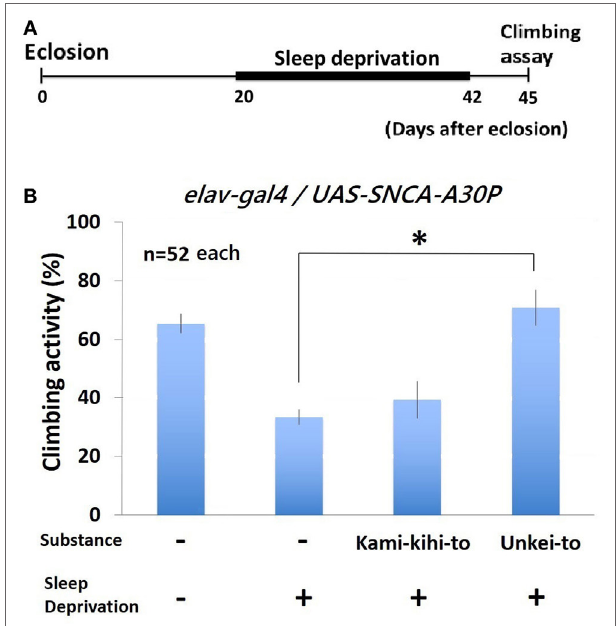
FigUre 4 | Climbing activity of A30P Parkinson’s disease (PD) model flies was dramatically decreased by sleep deprivation. (a) Schematics of sleep deprivation assay experiment. A30P PD model flies were given substances (0.25%) since eclosion. From 20 to 42 days after eclosion, sleep deprivation was repeated minutely between ZT 12 and 16. Climbing assay was performed at 45 days after eclosion. (B) Climbing activity of A30P PD model Drosophil a was recovered by Kampo medicine. Each experiment was repeated for three times ( n = 52 flies each). * indicates significant differences ( p <